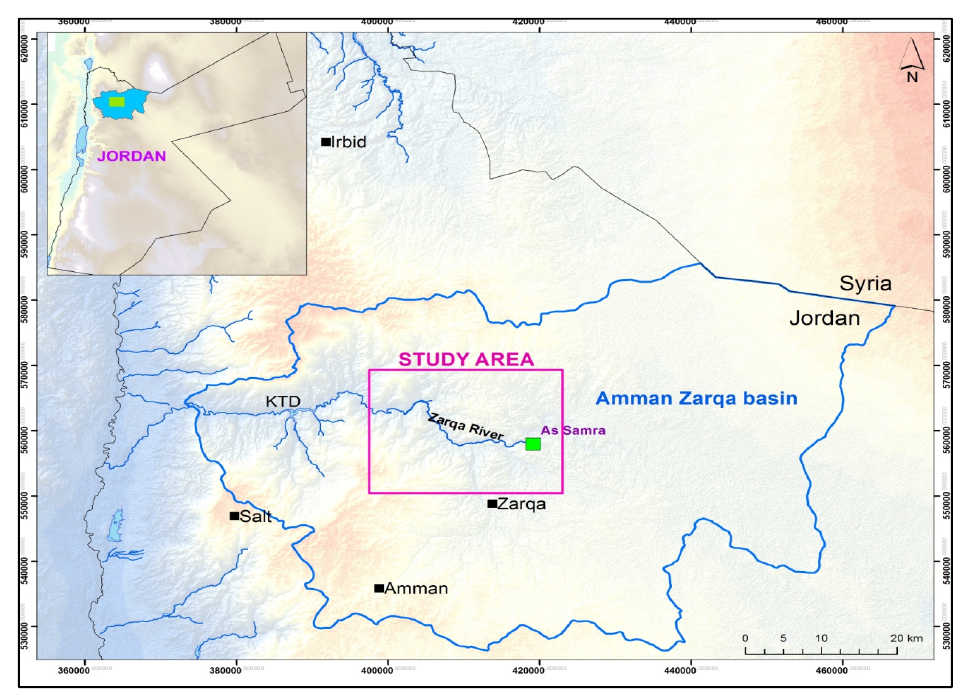
Figure 1. Location of the study area.